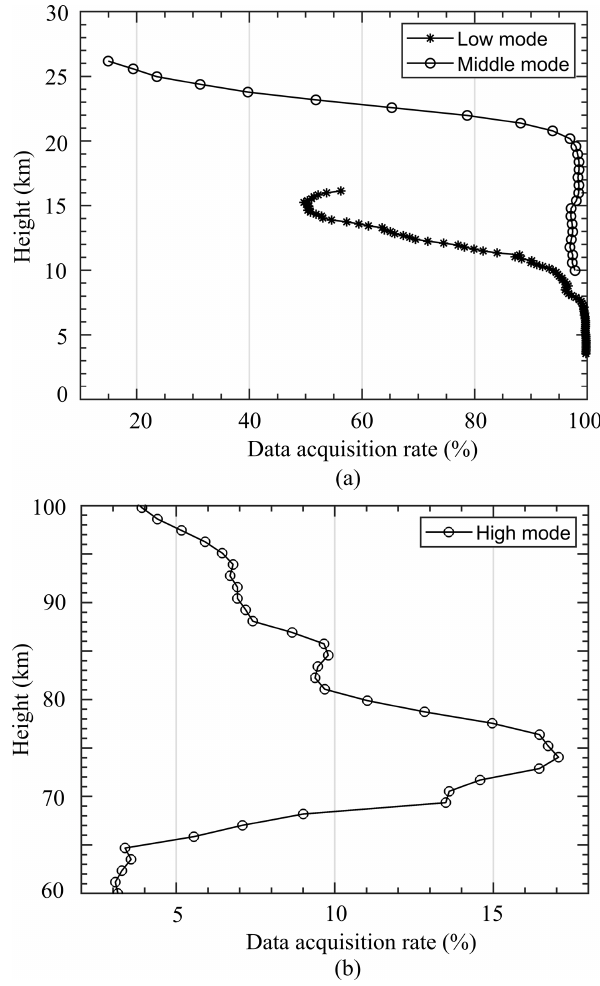
Figure 8. The average data acquisition rate from the Wuhan MST radar in low and middle (a) and high (b) observation modes during January 2016 to December